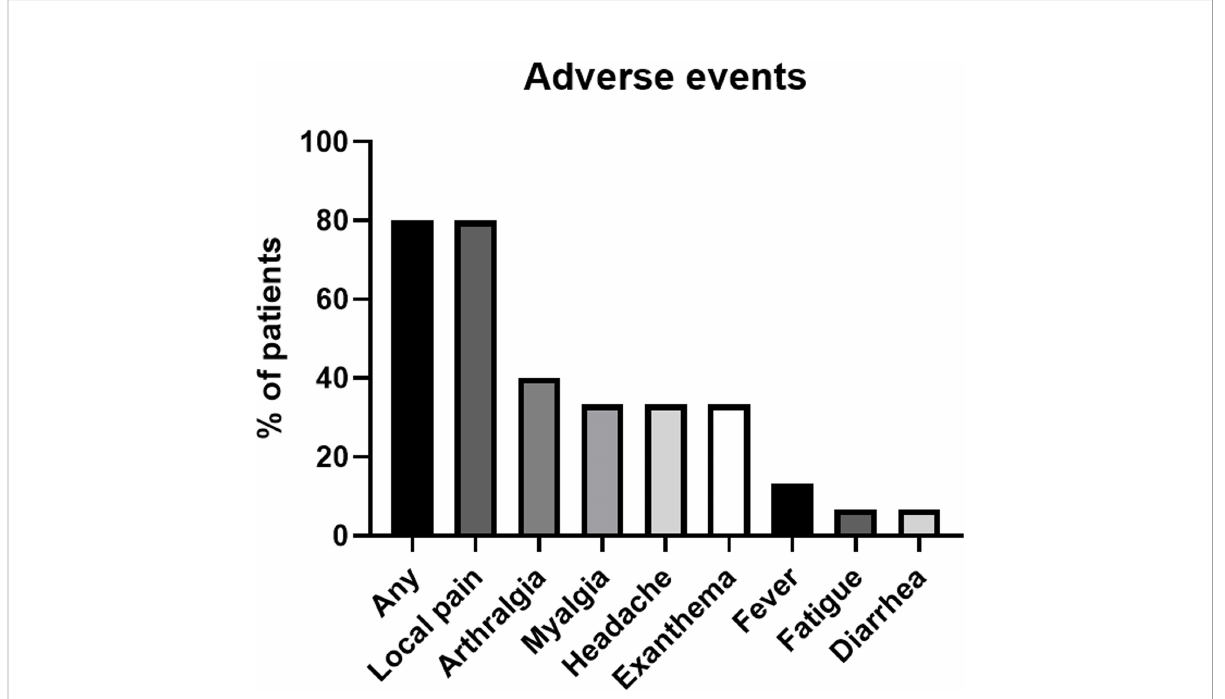
FIGURE 6 The spectrum of adverse events as a proportion of patients (%) reported by patient clinical questionnaire within the 7-day follow-up period after booster